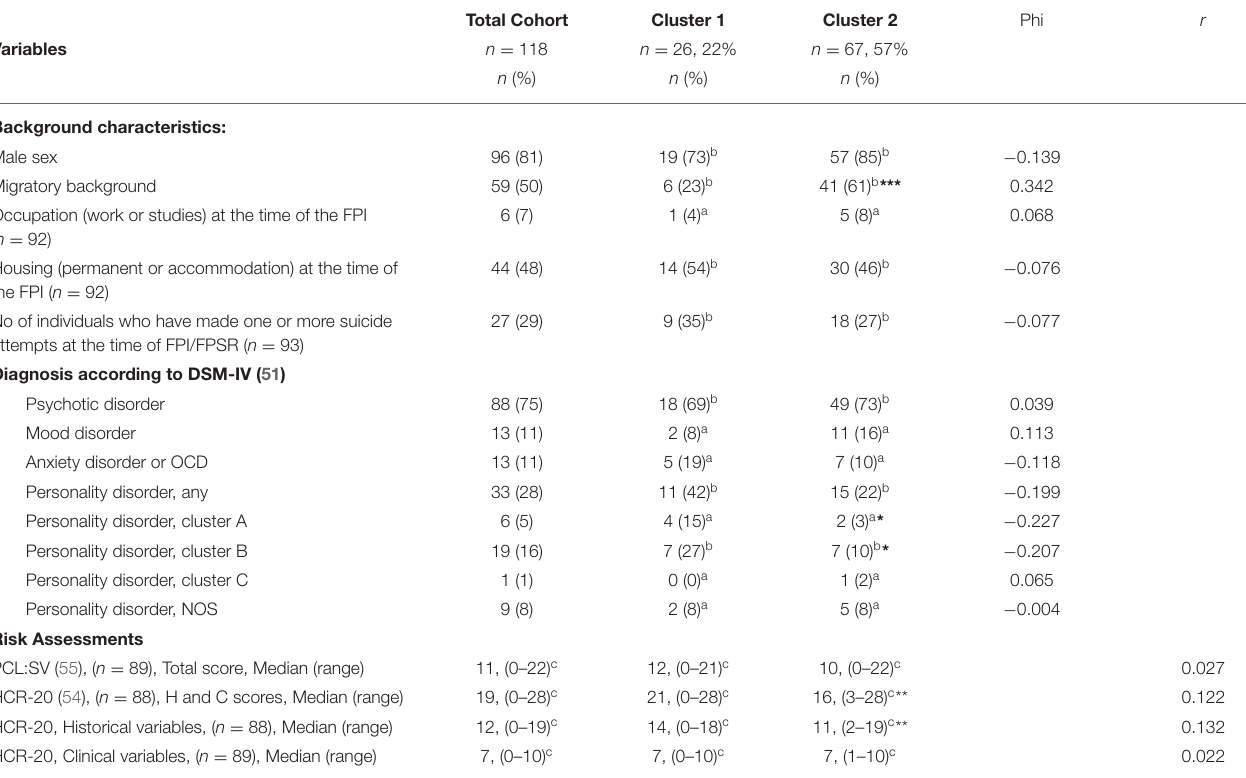
TABLE 1 | Background and clinical characteristics of the cohort and comparisons between the two